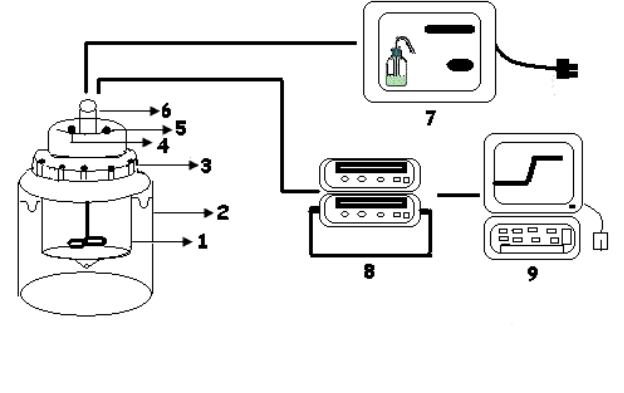
Figure 1 . Isoperibolic titration calorimeter. (1) Cell; (2) Jacket; (3) Lid; (4-5) Holes for sensors; (6) Stirrer; (7) Injection system; (8) Capture system; (9) Computer.